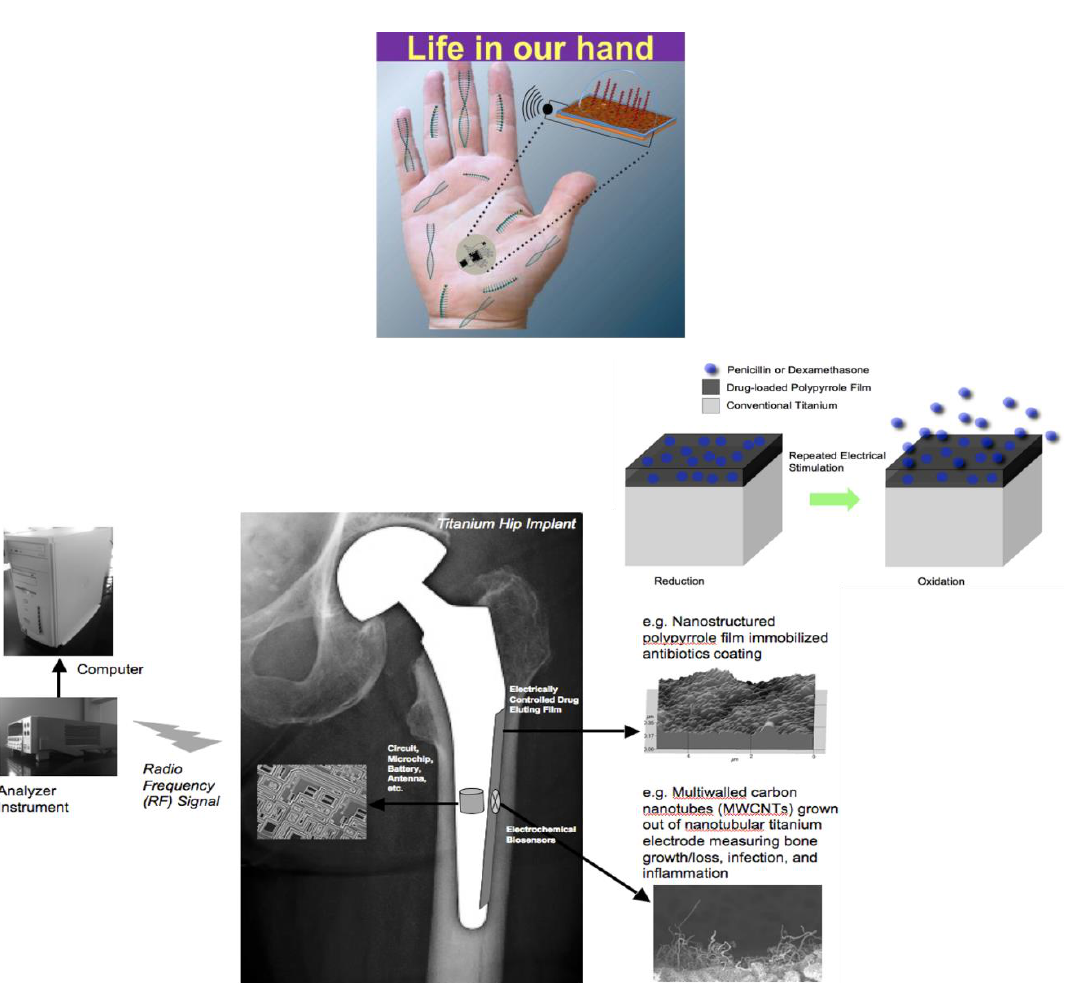
Figure 1. The SMARTHIP TM can detect cell presence and function next to a hip implant in real time and possesses on-demand release of nanoparticles, antibiotics, anti-inflammatory agents, and more to ensure implant success. Further, all information can be sent to a hand-held device to provide personalized medicine.